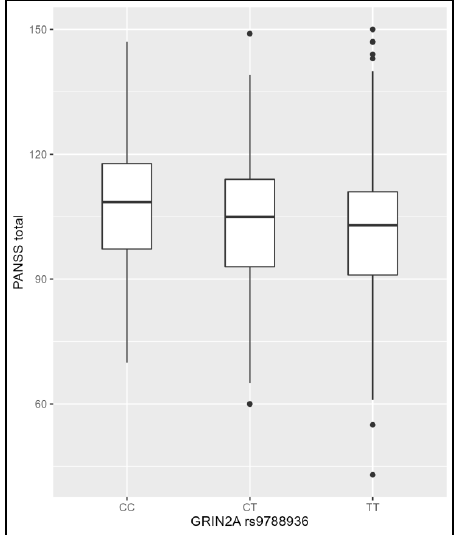
Figure 1. Association between GRIN2A rs9788936 and total scores on the Positive and Negative Syndrome Scale (PANSS). Syndrome Scale